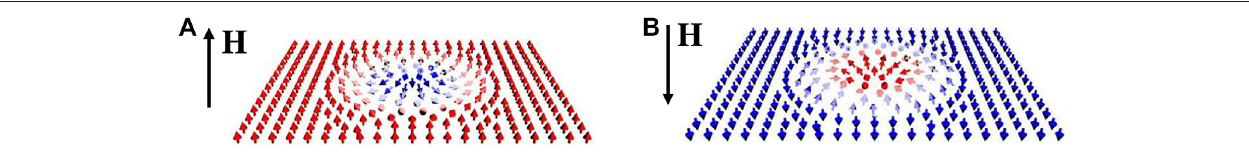
FIGURE 1 | Pictorial representation of a Néel magnetic skyrmion in two magnetization textures. (A) Perpendicularly magnetized ferromagnet hosting an outwardly (chirality χ (cid:2) + 1) Néel magnetic skyrmion with polarity p = − 1. (B) Perpendicularly magnetized ferromagnet hosting an inwardly (chirality χ (cid:2) − 1) Néel magnetic skyrmion with polarity p = +1. H lies along the z-axis [positive direction in (A) and negative direction in (B)